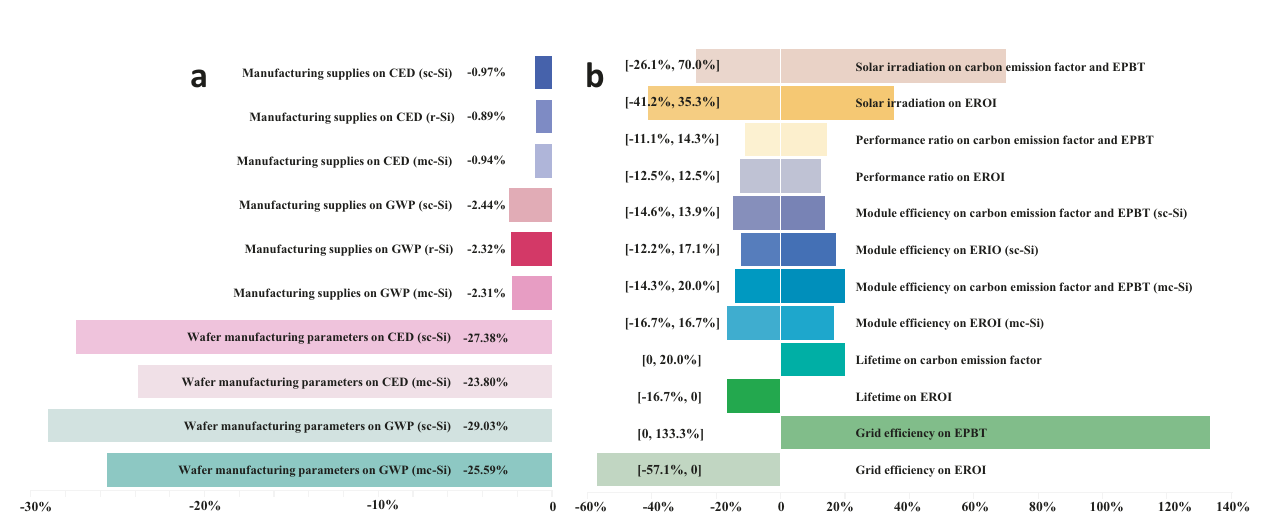
Fig. 7 | Sensitivity analysis of various parameters on cumulative energy demand, global warming potential, carbon emission factor, energy payback time, and energy return on investment estimations. The sensitivity analysis includes: ( a ) manufacturing supply chain structure (number of representative